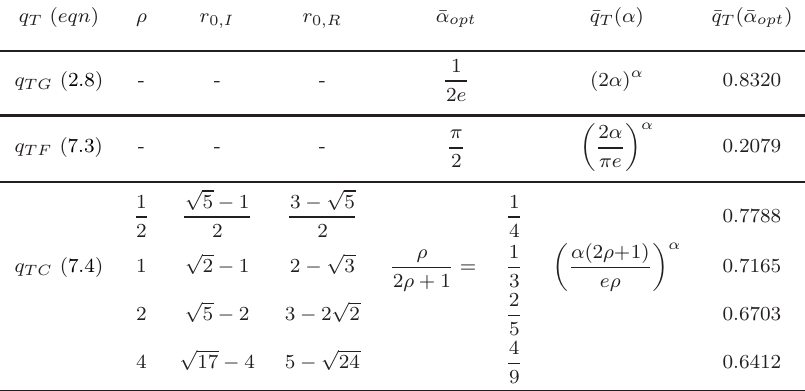
Table 7. Comparison of ¯ α opt , ¯ q T ( α ) and ¯ q T (¯ α opt ) corresponding to expressions for q T